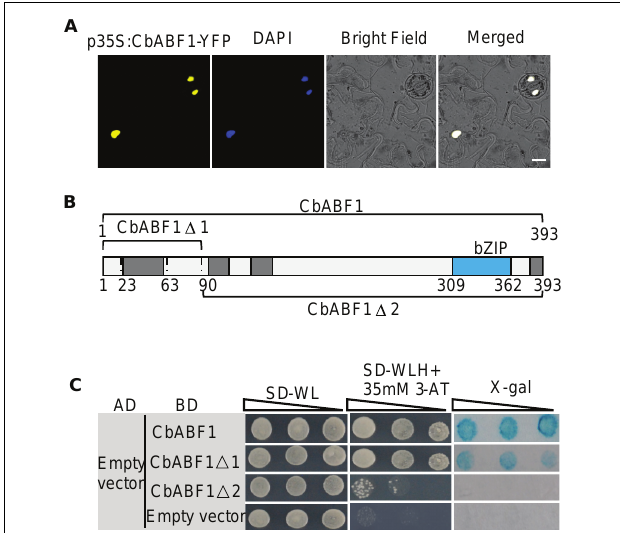
FIGURE 4 | CbABF1 subcellular localization and transactivation activity assays. (A) Localization of p35S:CbABF1-YFP in tobacco leaves, DAPI staining was used to indicate the nuclei. Bars = 15 µ m. (B) A schematic diagram of the CbABF1 protein sequence and its truncated fragments that were fused to the GAL4 DNA-binding domain expressed from the yeast vector pGBKT7. The bZIP domain and four conserved domains are indicated. (C) Transactivation analysis of CbABF1 in yeast. The constructs for expression of the GAL4 DNA-binding domain fused with CbABF1, CbABF1 (cid:49) 1, and CbABF1 (cid:49) 2 were co-transformed with empty pGADT7 into yeast strain AH109, respectively. A 10-fold dilution series (10 − 1 to 10 − 3 ) of transformants was spotted on SD medium without Leu and Trp (–LW), or without Leu, Trp, and His (–LWH) plus 35 mM 3-amino-1,2,4-triazole (3-AT). The plates were incubated at 30 ◦ C for 4 days and subjected to the X-gal assay. Empty pGBKT7 with empty pGADT7 was used as the negative control.